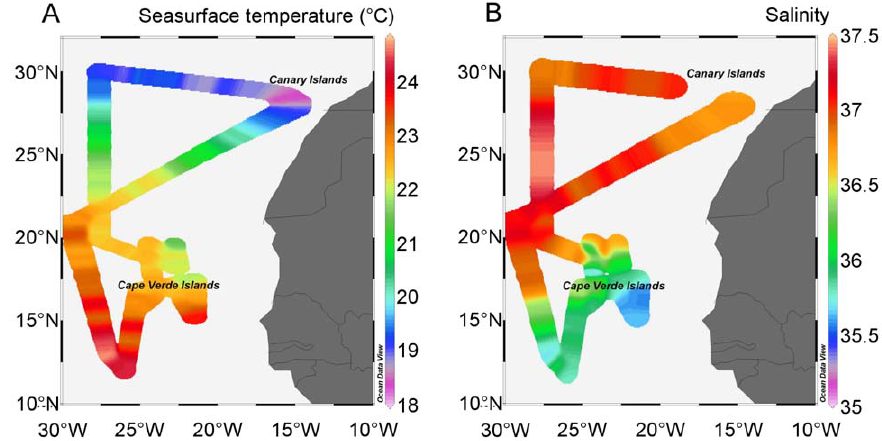
Figure 2. The sea surface (A) temperature ( 6 C) and (B) salinity during the P332 cruise.